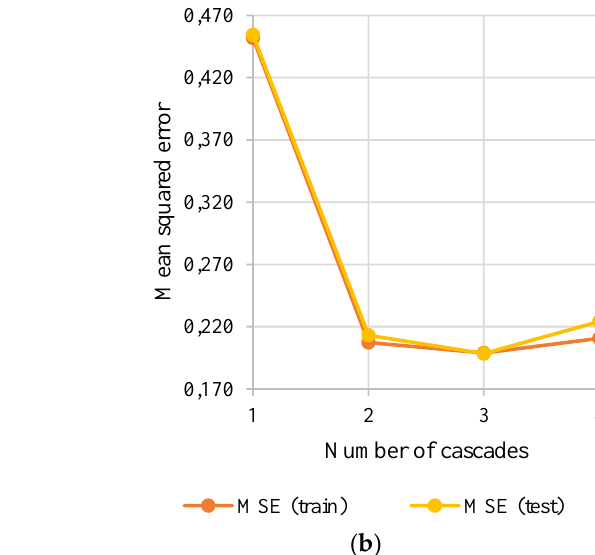
Figure 6. Influence of the proposed scheme’s levels on the prediction accuracy of the proposed ensemble scheme: ( a ) MAE; ( b ) MSE. The ox -axis, in this case, indicates the ensemble levels (1, 2, 3, and 4).